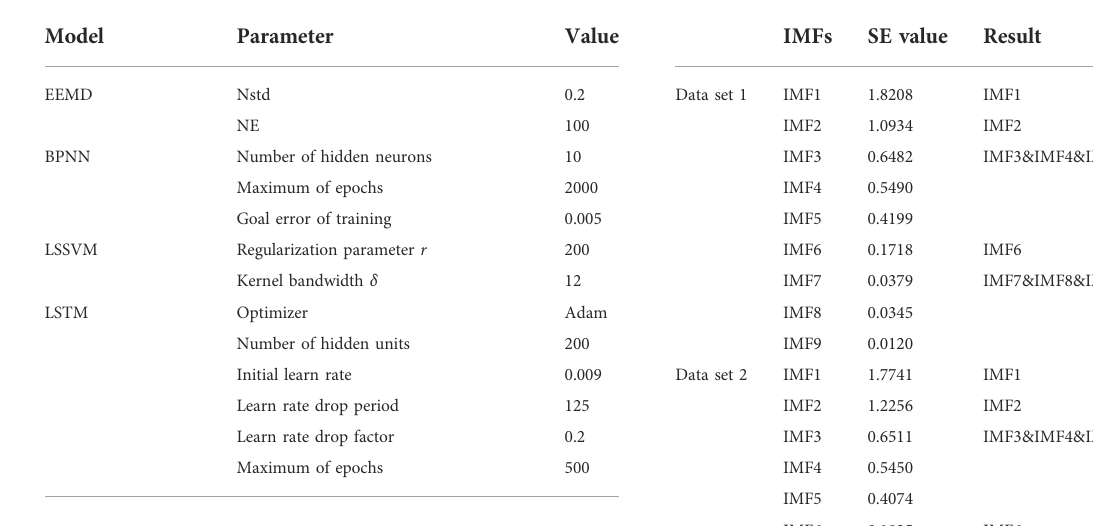
TABLE 4 EEMD subsequences and